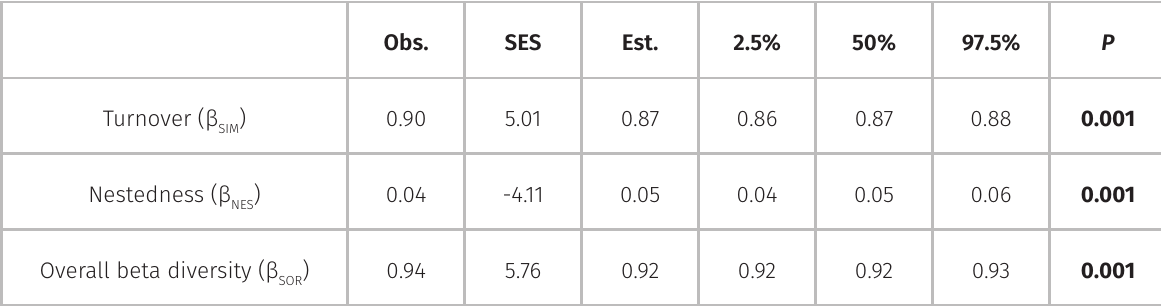
Overall beta diversity (β